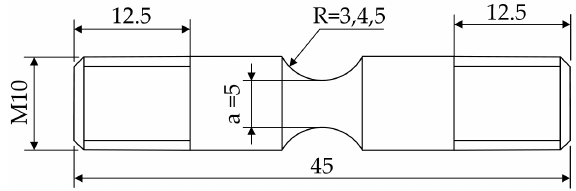
Figure 4. Notched sample for the specified triaxiality (units: mm).